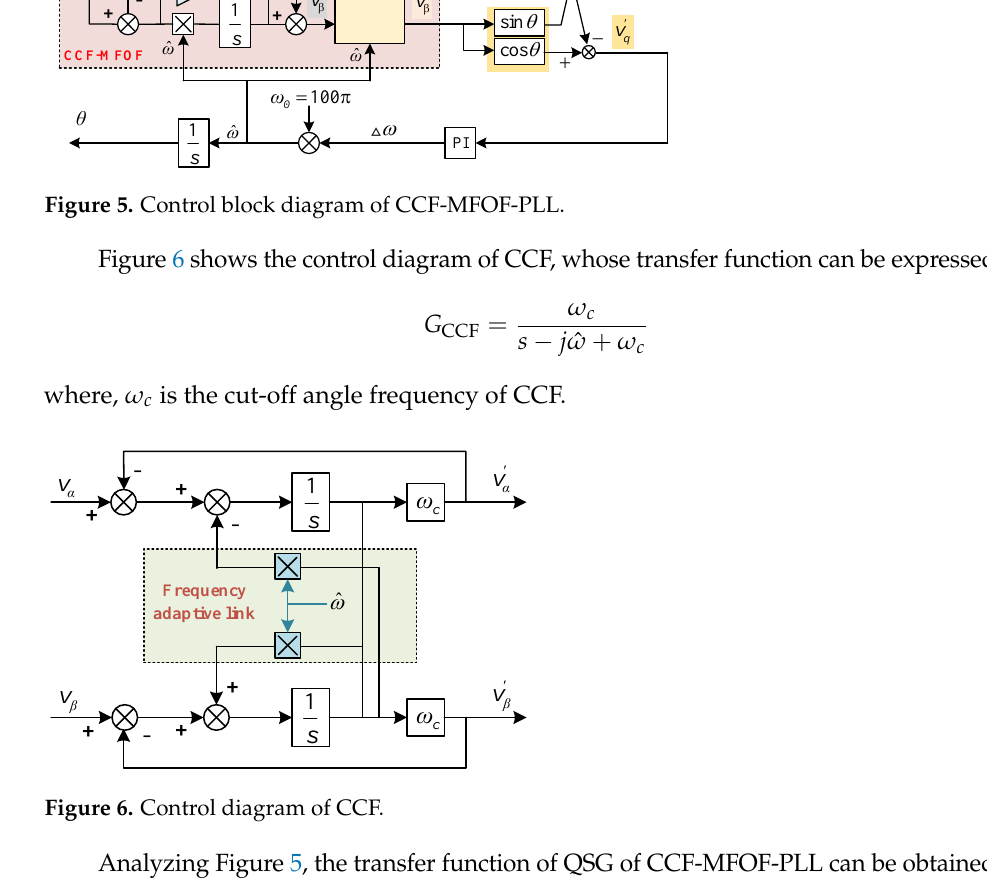
= Figure 4. Dynamic response curve of Q (s). In the weak grid, the intersection frequency of the magnitude – frequency characteris- tic curve between the inverter impedance and grid impedance is usually in the range of several hundred Hz. In order to suppress the influence of the additional term brought by PLL on the stability of the inverter, the PLL needs to have the ability to adequately atten- uate the signal in the range of at least 100 – 600 Hz. Therefore, a modified first-order filter